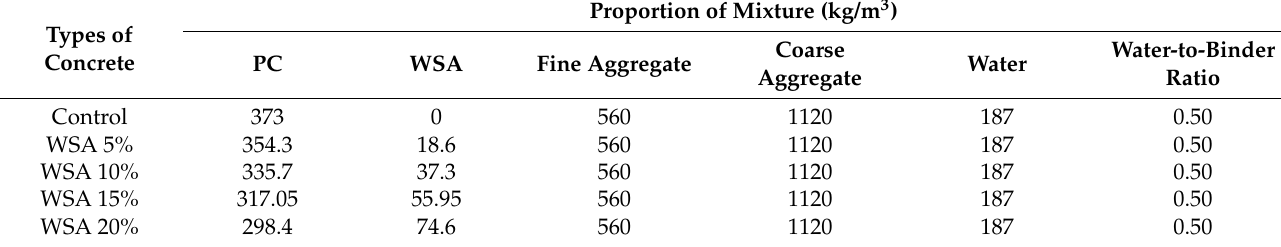
Table 3. Mixture proportion of